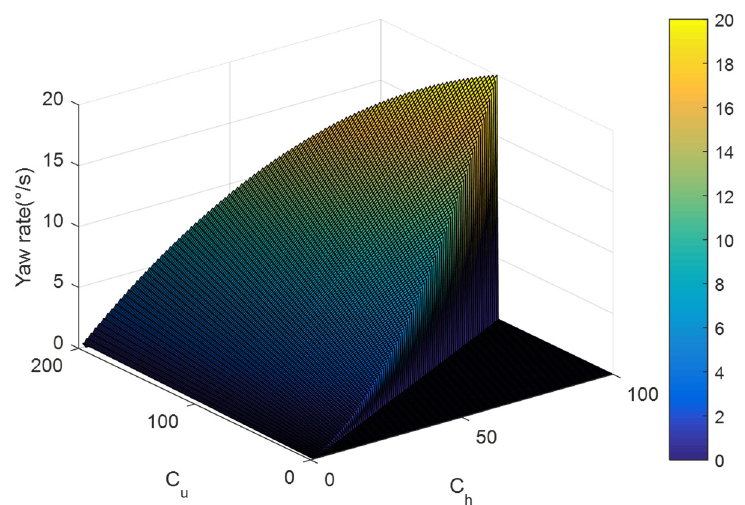
Figure 9. The restriction of the yaw rate for the USV.